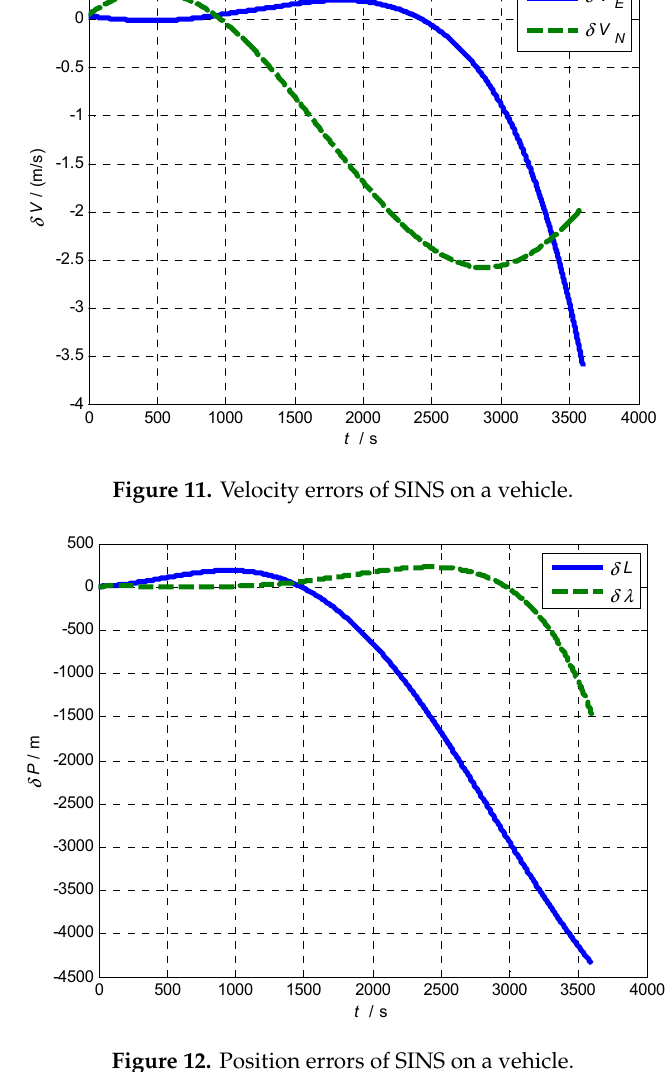
Figure 12. Position errors of SINS on a vehicle.